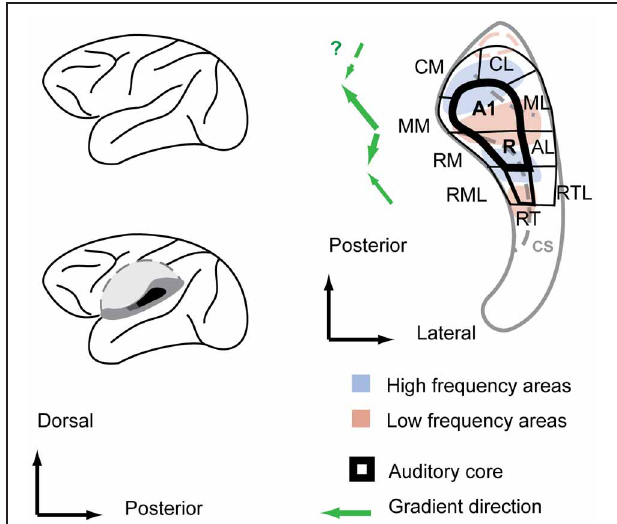
FIGURE 1 | Functional field organization of the monkey auditory cortex superimposed over the frequency response areas and anatomical features of the macaque superior temporal plane. Left: a sagittal view of the macaque brain (top) with the superior temporal plane (dark gray shadings) exposed by cutting out the operculum (bottom). Right: within the superior temporal plane, the core area, highlighted with bold stroke, is surrounded by belt fields. Anatomical features are designated by light gray color shade. Main gradient directions from low to high of the frequency response areas are indicated with green arrows left of the scheme. CS, circular sulcus. Auditory field labeling according to Hackett et al. (Hackett et al., 1998; Hackett,